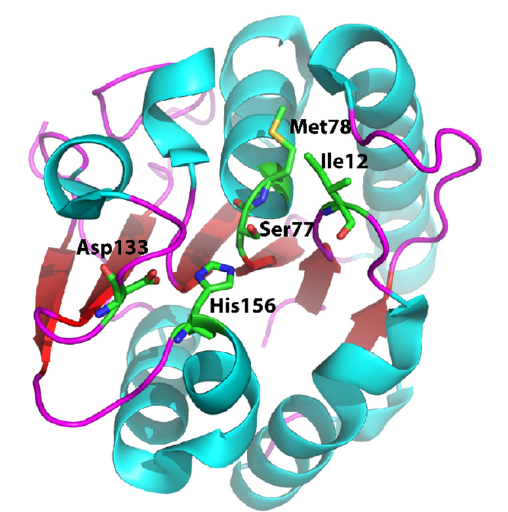
Figure 1. Bacillus subtilis lipase A (BSLA) is the smallest serine hydrolase with an α / β hydrolase fold. With only 181 amino acids, it has a molecular weight of 19 kDa. The depicted BSLA structure is pdb 1R50 and the catalytic triad His156, Ser77 and Asp133 and the oxyanion hole Ile12 and Met78 are highlighted. The figure was created with PyMOL.